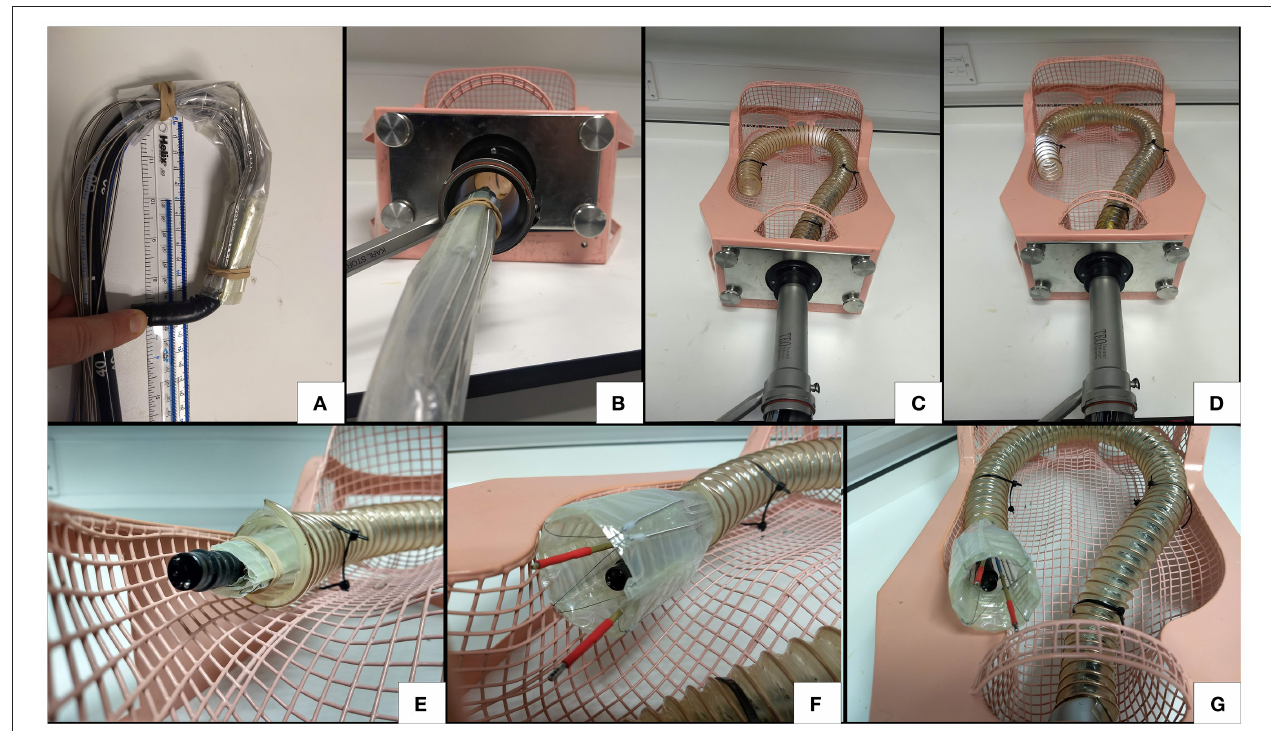
FIGURE 10 | Demonstration of flexibility, insertion and deployment of the CYCLOPS (A) the endoscope is still free to bend (B) the CYCLOPS robot around the endoscope fits comfortably through a trans-anal port (C) the endoscope advances around curved, narrow path (D) further advancement (E) the assembly before deployment (F) deployed CYCLOPS robot ready to carry out surgical tasks (G) overview of robot after navigating the curved path and deploying.